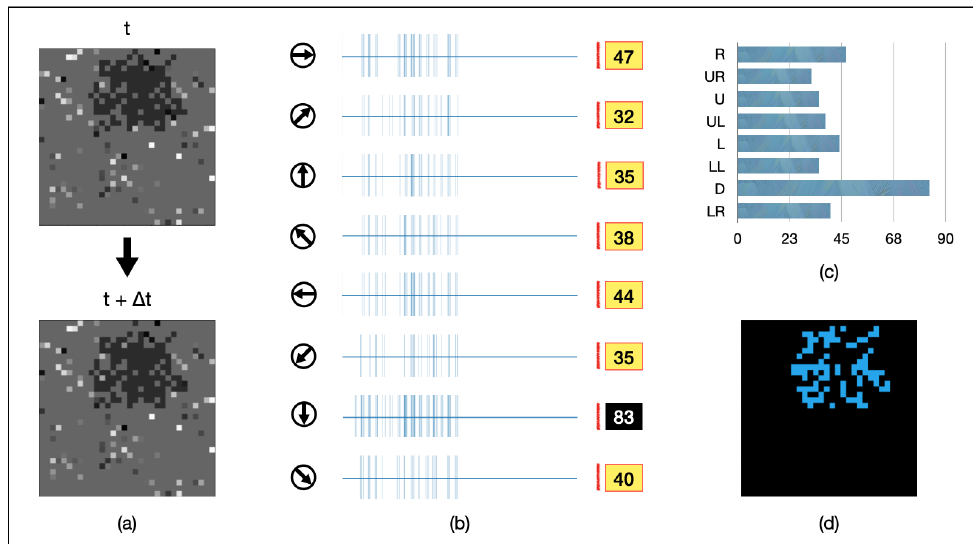
Figure 11. An AVS motion direction detection instance in static background noise: ( a ) two successive frames of a downward motion of an 128-pixel object; ( b ) activation map of the eight LMDNs during scan; ( c ) LMDNs activations are counted by a bar chart; ( d ) activated pixels by all the LMDNs during detection process are marked by